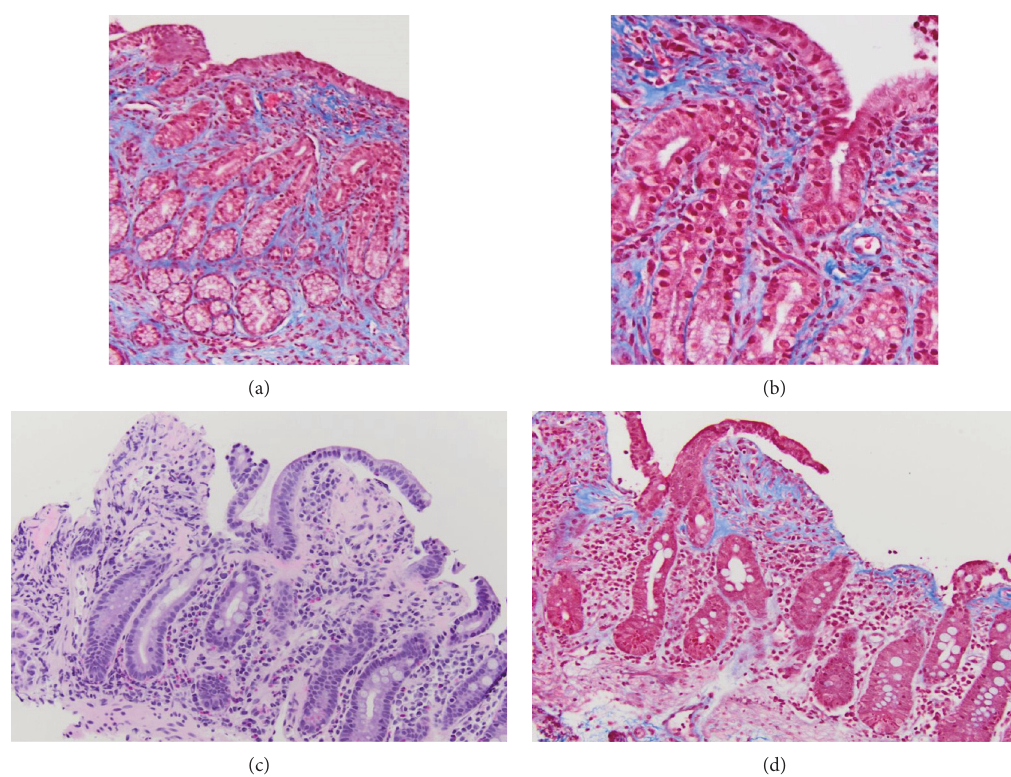
Figure 1: Histopathologic findings of collagenous gastroenterocolitis. Increased subepithelial collagen. (a) Collagenous gastritis (stomach, trichrome). (b) Collagenous gastritis, high magnification (stomach, trichrome). (c) Collagenous duodenitis (duodenum, H&E). (d) Collagenous duodenitis (duodenum,